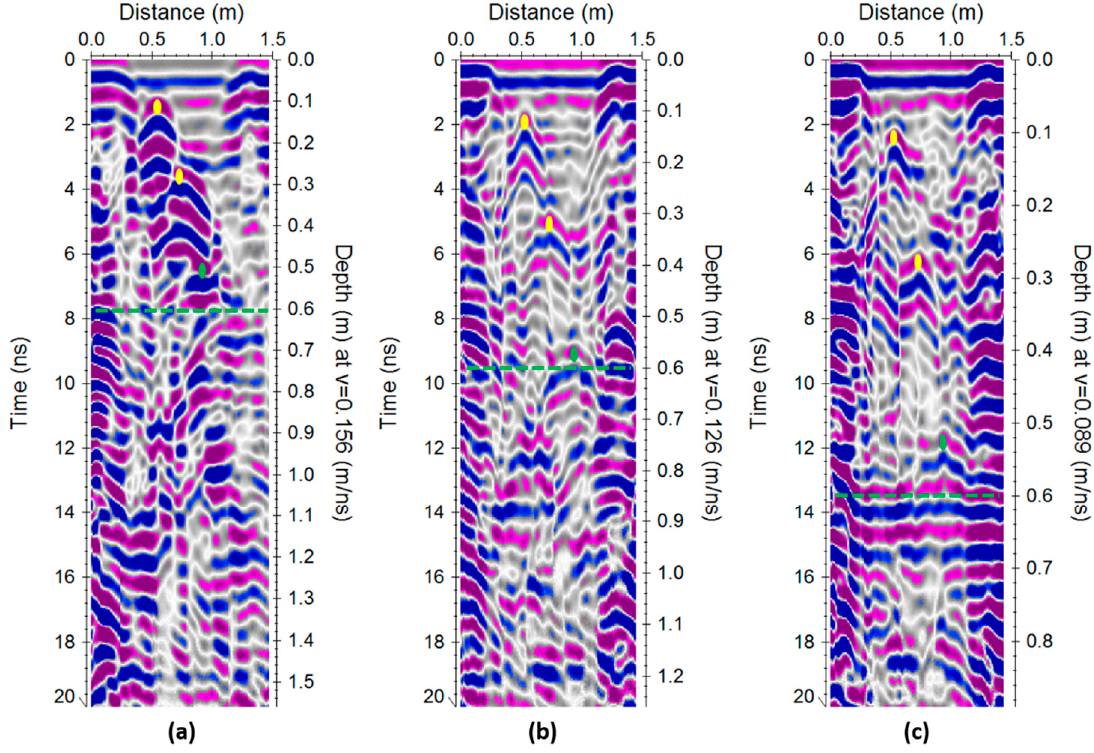
Figure 11. GPR sections in the hamra small soil box. The moisture contents were: ( a ) 1.0 ± 0.5% (air-dried); ( b ) 3.5 ± 1.5%; ( c ) 10.5 ± 0.9% (saturation).